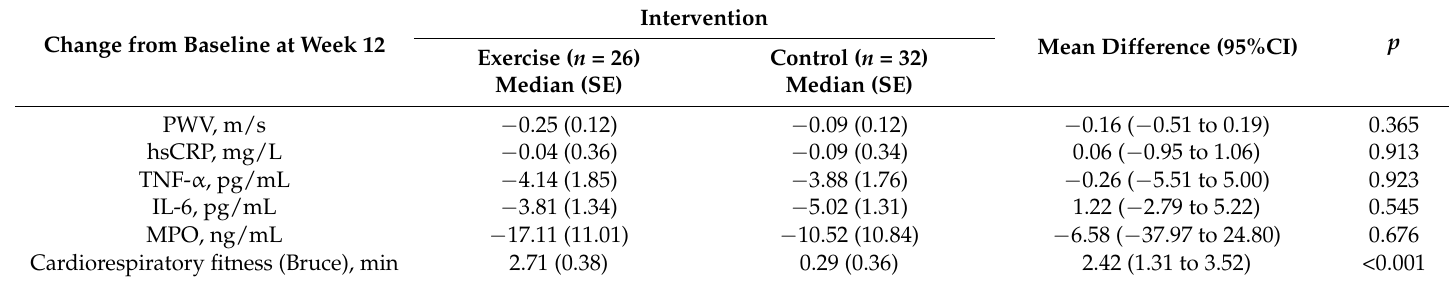
Table 4. Sensitivity analyses: Baseline-observation carried forward imputation assessing the effects of 12-week progressive aerobic exercise on arterial stiffness, inflammation, oxidative stress, and cardiorespiratory fitness in women with systemic lupus